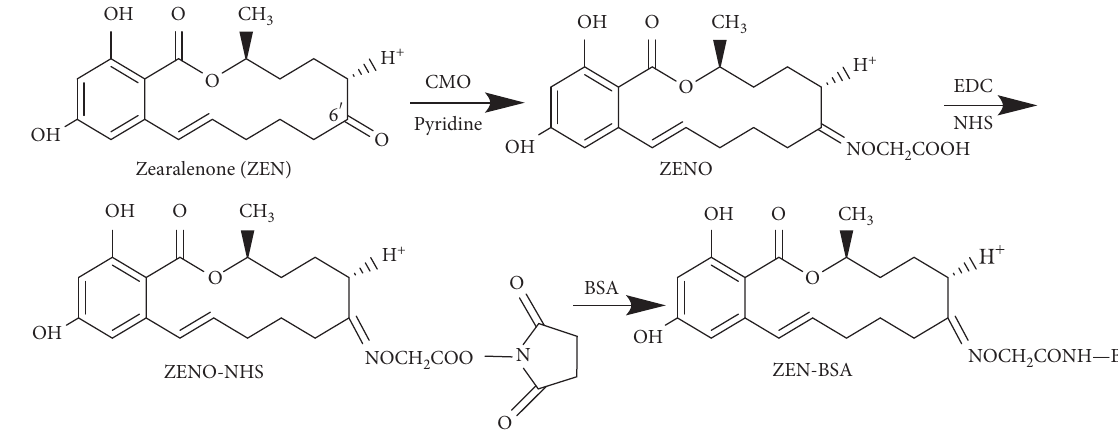
Figure 2: Synthesis route of the ZEN-BSA by the OAE